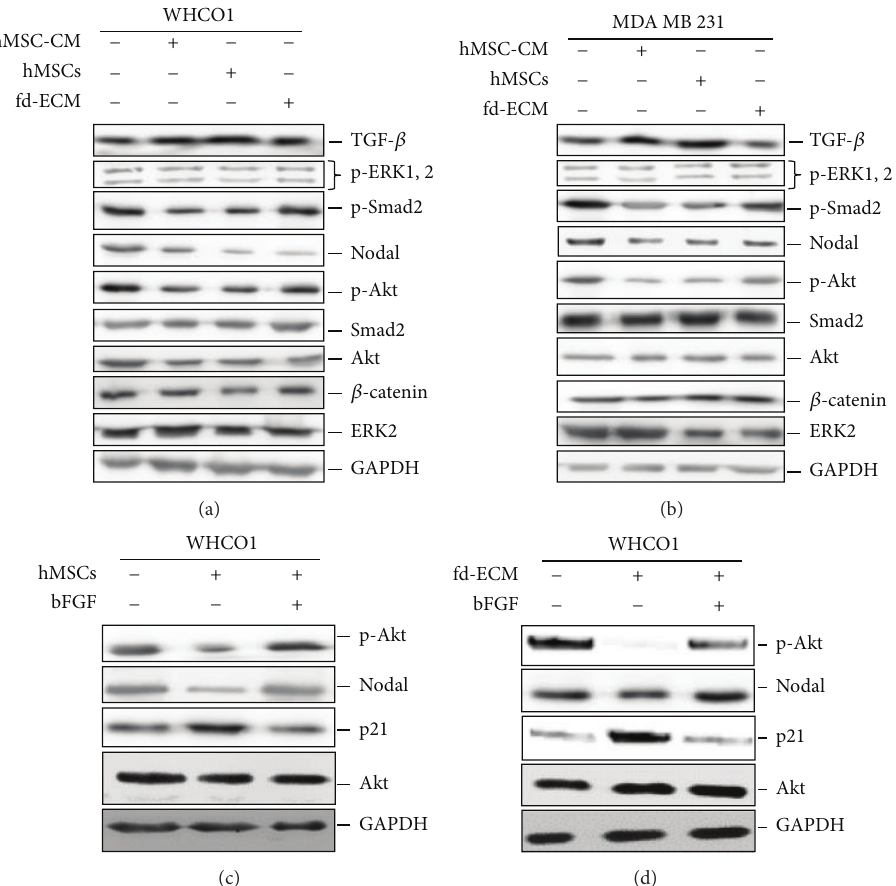
Figure 7: MSCs and the fd-ECM downregulate tumorigenic signaling pathways. (a) Western blot analysis of lysates from WHCO1 cells cocultured with MSCs or cultured on an fd-ECM for 48 hrs showing expression of TGF- 𝛽 , p -ERK 1,2, p -Smad 2, Nodal, p -Akt, and 𝛽 -catenin. (b) Western blot analysis of lysates from MDA MB 231 cells cocultured with MSCs or cultured on an fd-ECM for 48 hrs showing expression of the same genes as in (a). ((c)-(d)) Activation of the Akt pathway reverses the effect of hMSCs and fd-ECM on p21 expression. Cocultured WHC01 (a) and those plated on fd-ECM (b) were treated with 10 nM basic fibroblast growth factor for 48 hrs. Western blot analysis was performed on the protein lysates to determine p-Akt, Nodal, and p21